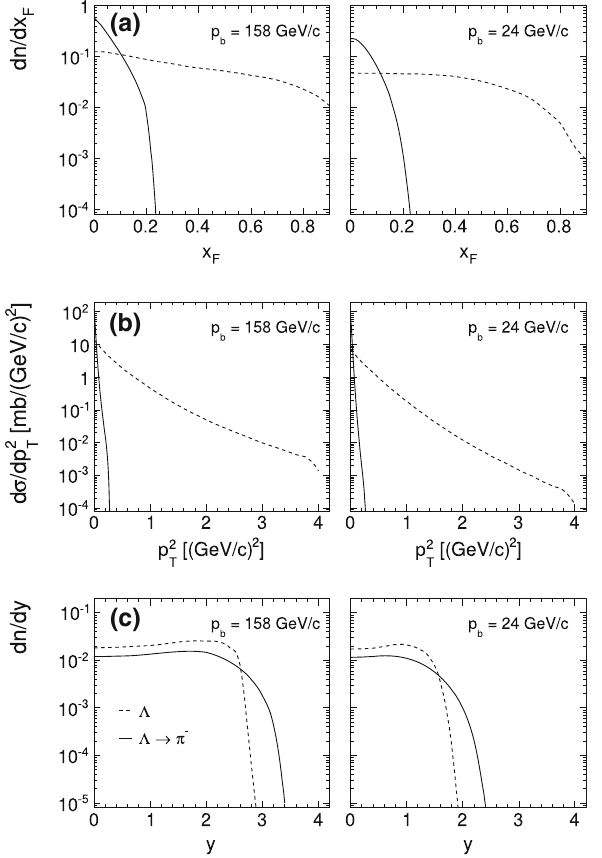
Fig. 20 a dn / dx F as a function of x F , b d σ/ dp 2 and c dn / dy asafunctionofrapidityfor p beam =158and24GeV/c.The full lines correspond to the π − yields, the broken lines to the parent Λ